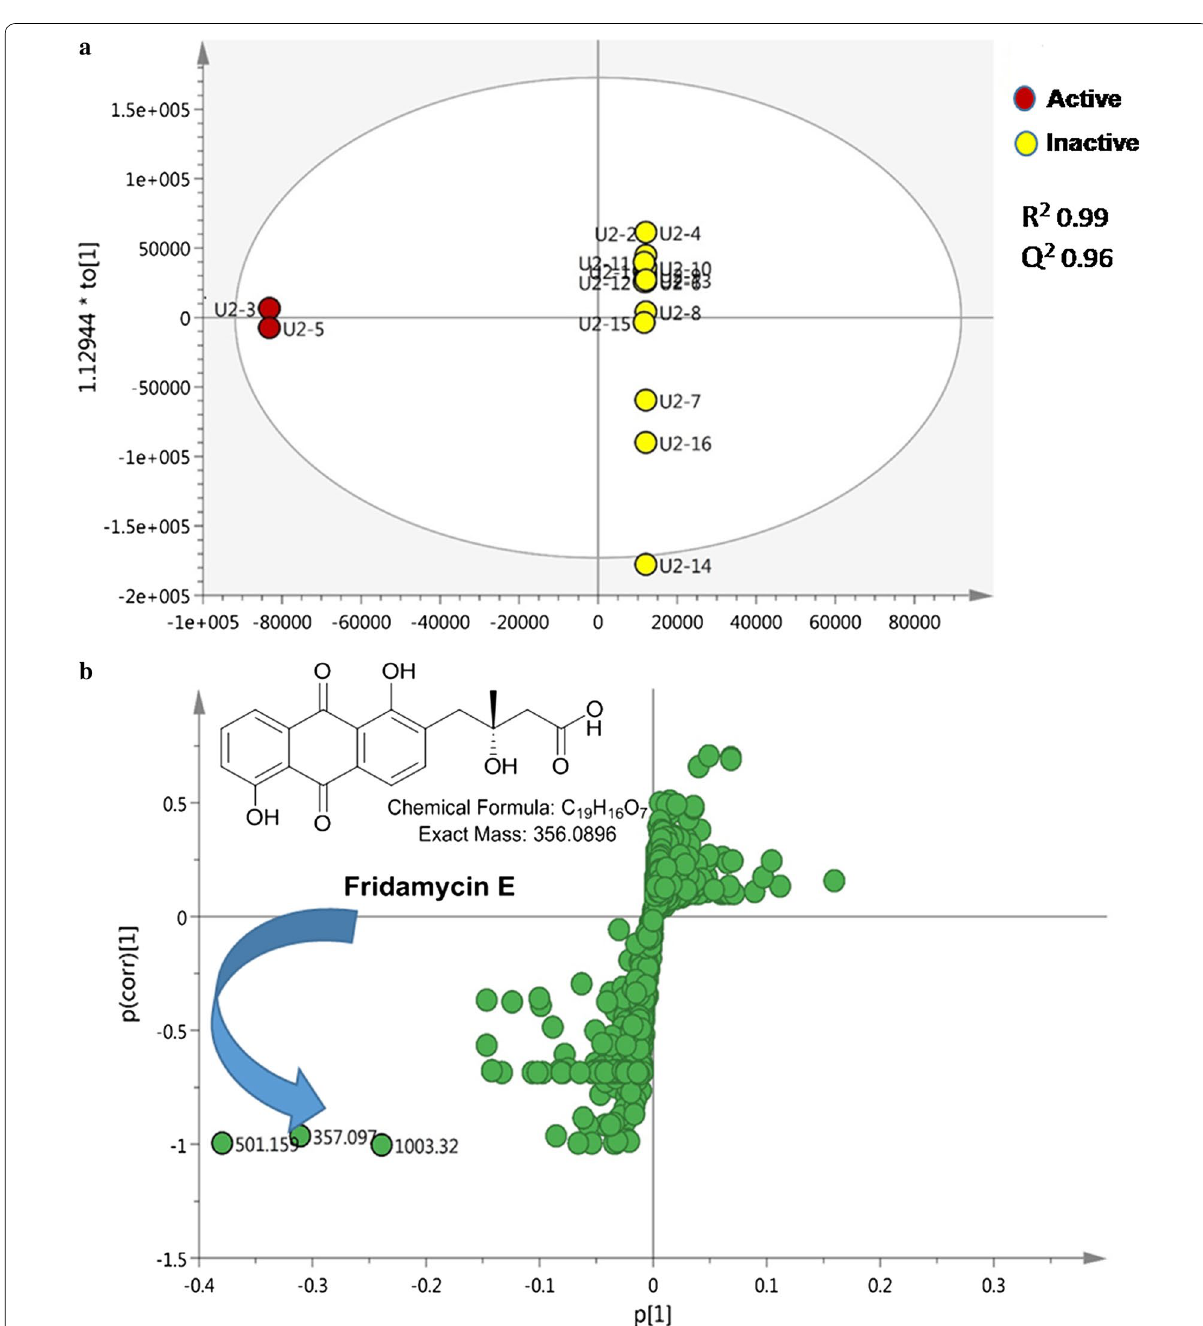
Fig. 2 a OPLS‑DA score plot of active (red circle) versus inactive fractions (yellow circle). b S‑loading plot showing the putatively active